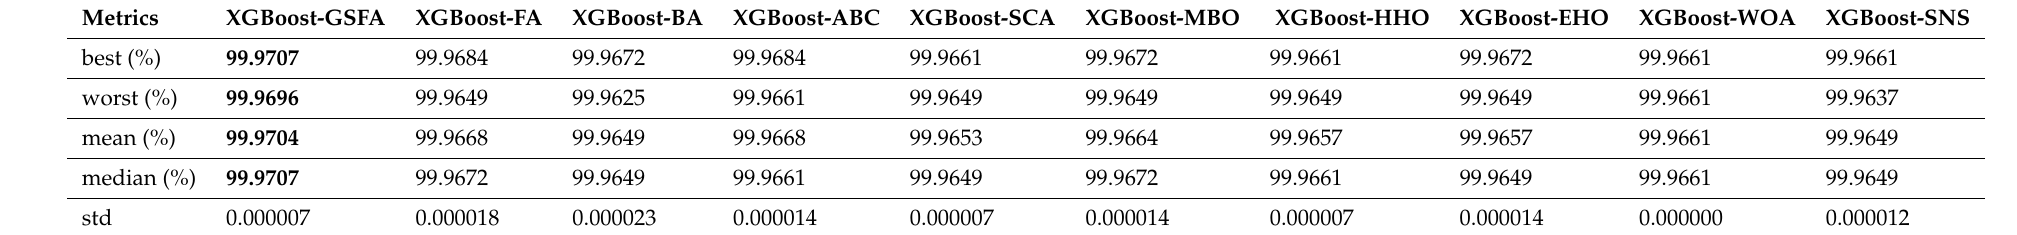
Table 4. XGBoost Credit Card Fraud NO SMOTE—general